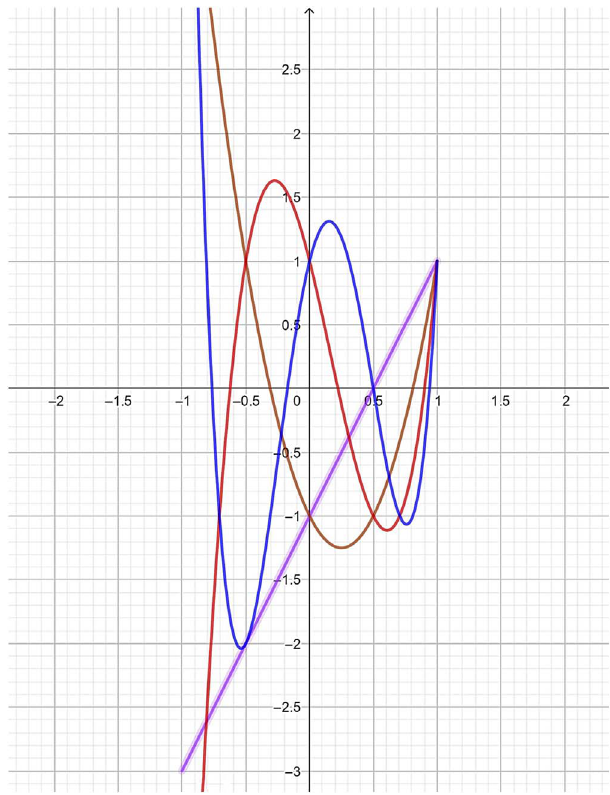
Figure 2. V k ( x ), k = 1, 2, 3, 4. (1) Violet; (2) brown; (3) red; (4) blue.